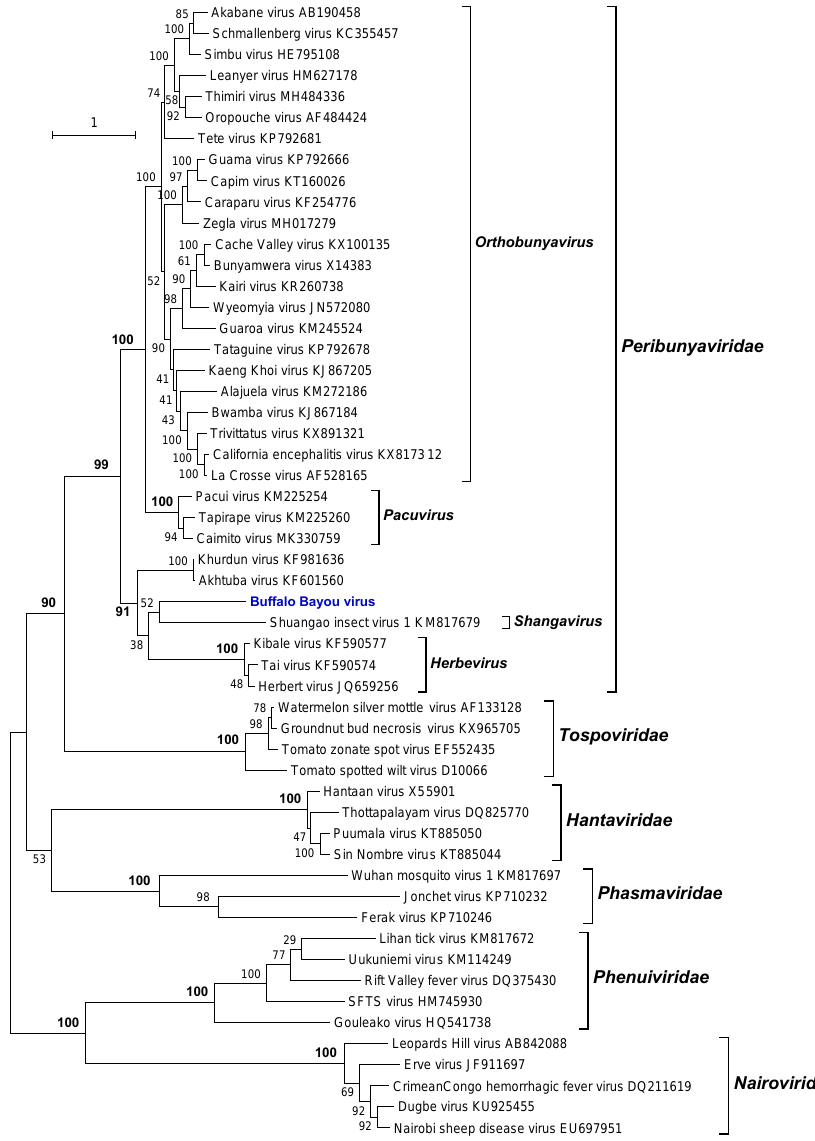
Figure 5. Maximum likelihood phylogenetic tree of the RNA-dependent RNA polymerase (L protein) amino acid sequences for representative members of the order Bunyavirales with emphasis on the family Peribunyaviridae . Branch lengths are proportional to the number of nucleotide substitutions per site. Values for bootstrap support proportion (BSP) were determined from 100 bootstrap iterations. BSP values showing strong support for each of the key nodes are shown in bold. The position in the tree of BBAV is shown in blue. The Genbank accession numbers of all sequences are as